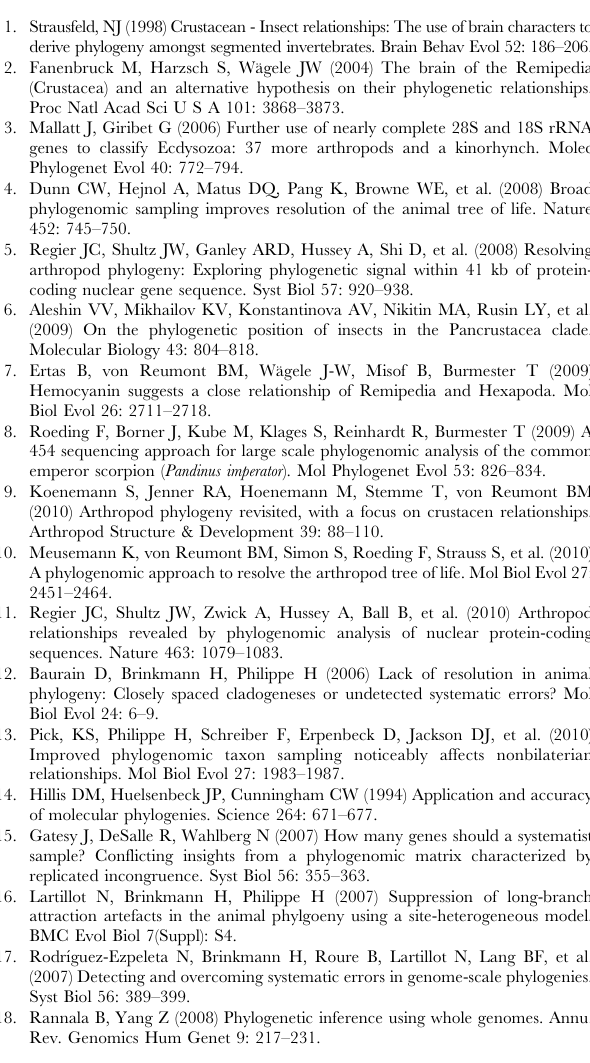
taxonomic groups that show particularly highly variable bootstrap values between replicates of the 50% matrices. Table S4 Bootstrap values based on analysis of data sets and subsets differing in their average rates of nonsynonymous change. The complete data set is split into two or three subsets based on average rates of nonsynonymous change of individual genes, and bootstrap analyses are performed to estimate the informativeness of the different rate category ranges. A subset of the Table-S4 results is also shown in Table 3. This Table-3 subset includes results only for those taxonomic groups that show particularly highly variable bootstrap values from differing rate category ranges of gene segments. Table S5 GenBank accession numbers (also cited in [11]). (DOC) Dataset S1 A Nexus-formatted data set that includes nucleotide sequence data ( nt123 ) for 80 taxa and 62 genes, slightly realigned relative to that in Regier et al., 2010 [11] (see Materials and Methods, Supplemetary Materials) and used principally for indel analysis. Sets of characters are defined and listed immediately